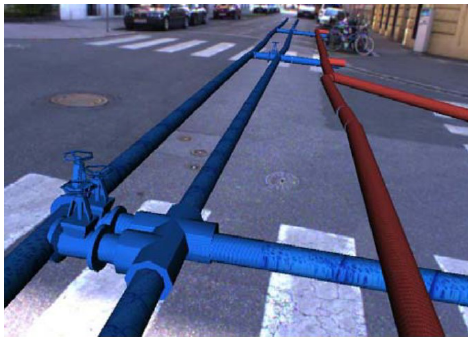
Figure 1. The virtual model appears floating (Schall et al.,